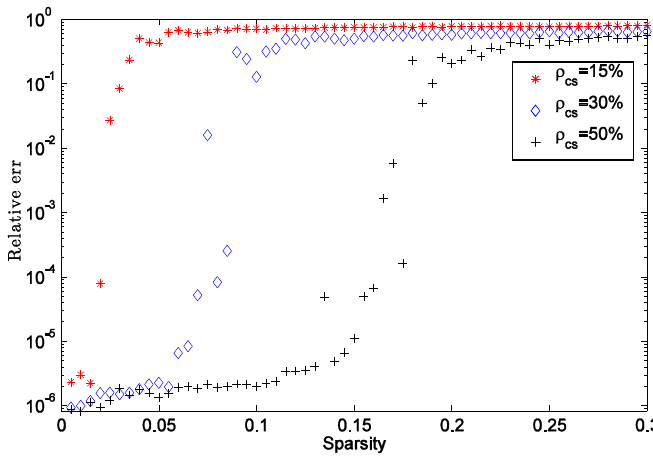
Figure 1. Sparse recovery performance with respect to signal